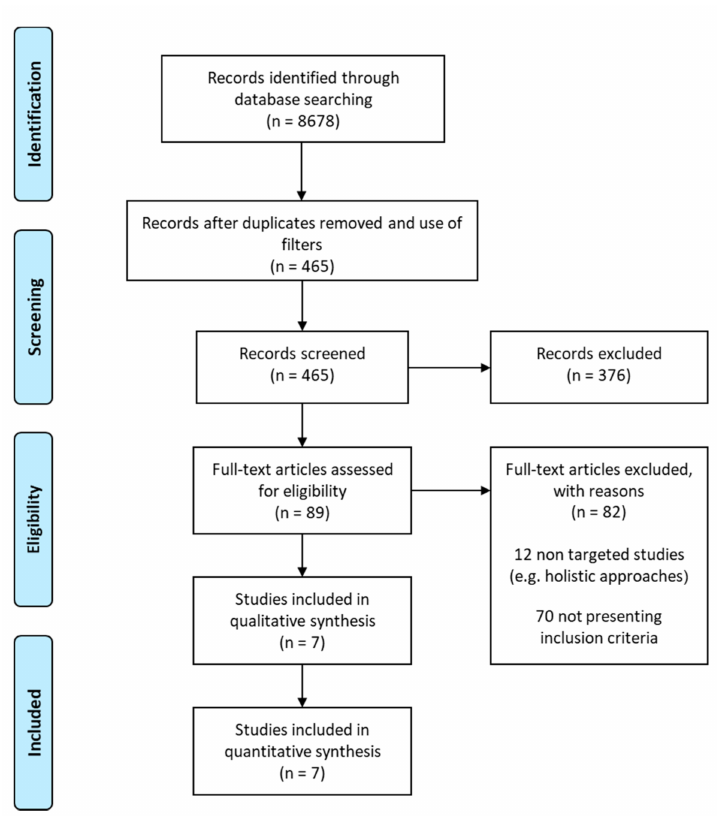
Figure 1. Flowchart of the literature search and data extraction. All studies used peripheral blood mononuclear cells (PBMCs), except one in which white blood cells were used, as biological material for analysis of modulations in gene expression (Table 1). Polyphenols from different origins, including olive oil and grape extracts, as well as pure compounds such as resveratrol, quercetin, or curcumin were used in the nutrigenomic studies. Doses varied in a wide range, as did the duration of interventions, which ranged from 2 or 5 h (acute studies) up to one year (chronic studies). Study populations included adults (men, women or both) of various age groups, up to 80 years old. There was also a large variability in the health status of study populations, ranging from healthy subjects with cardiometabolic risk factors, to patients with a diag- nosed cardiometabolic disease (Table 1). As for the modulation of gene expression, we identified 58 differentially expressed genes at mRNA level (one duplicate was removed), and 5 differentially expressed miRNAs (Table 1), which were subjected to bioinformatic